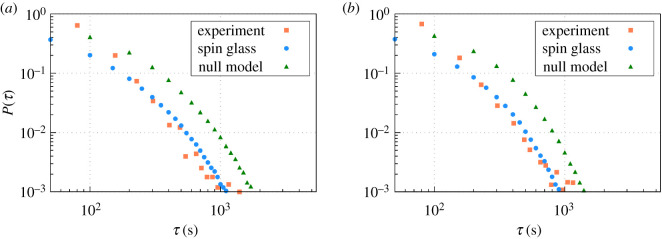
Probability distribution of switching times P(τ) during (a) regime A and (b) regime B. An ANOVA test with α = 0.05 for null differences with the experimental data leads to p-value = 0.86 (spin-glass) and p-value = 0.04 (null model) for regime A, and p-value = 0.82 (spin-glass) and p-value = 0.09 (null model) for regime B.